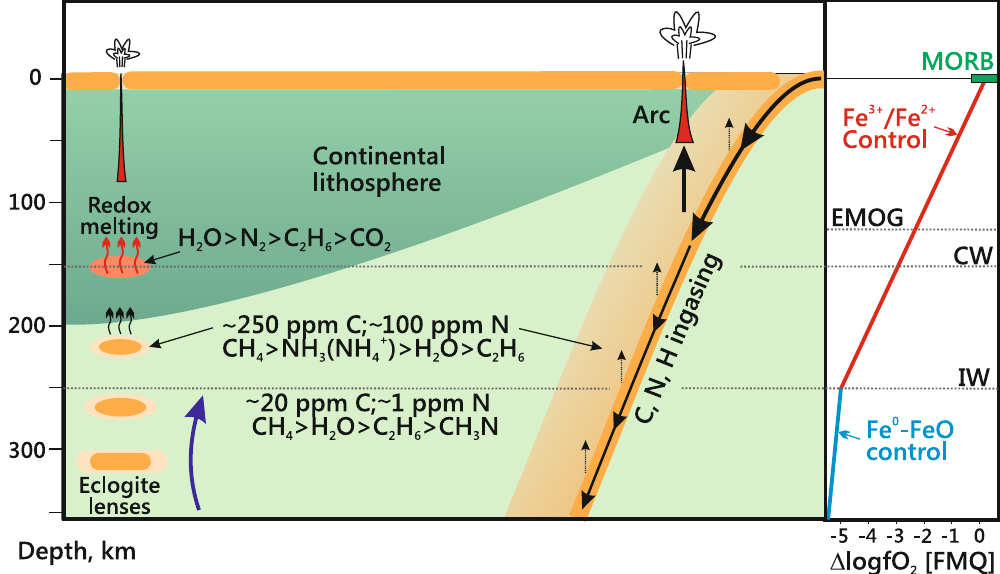
Figure 11. Schematic of the upper mantle volatile cycle and main carbon and nitrogen species of C-O-H-N fluids in depleted and enriched domains 38, 39 . Black arrows show paths and estimates of the relative magnitudes of carbon, nitrogen and hydrogen fluxes and blue arrow is mantle upwelling. Right panel: potential mantle f O 2 as a function of depth. The Fe 0 -FeO and Fe 3 + /Fe 2 + (equilibria involving the exchange of Fe 3 + and Fe 2 + between silicate minerals) curves are according to refs 1 and 56. Oxygen fugacity of CW (maximum H 2 O content in C-O-H fluids), EMOD/G (equilibria enstatite + magnesite = olivine + graphite/diamond) and MORB (mid- ocean ridge basalts) are according to refs 1 and 24. ‘Redox melting’ process at depths of 120–150 km is according to refs 1 and